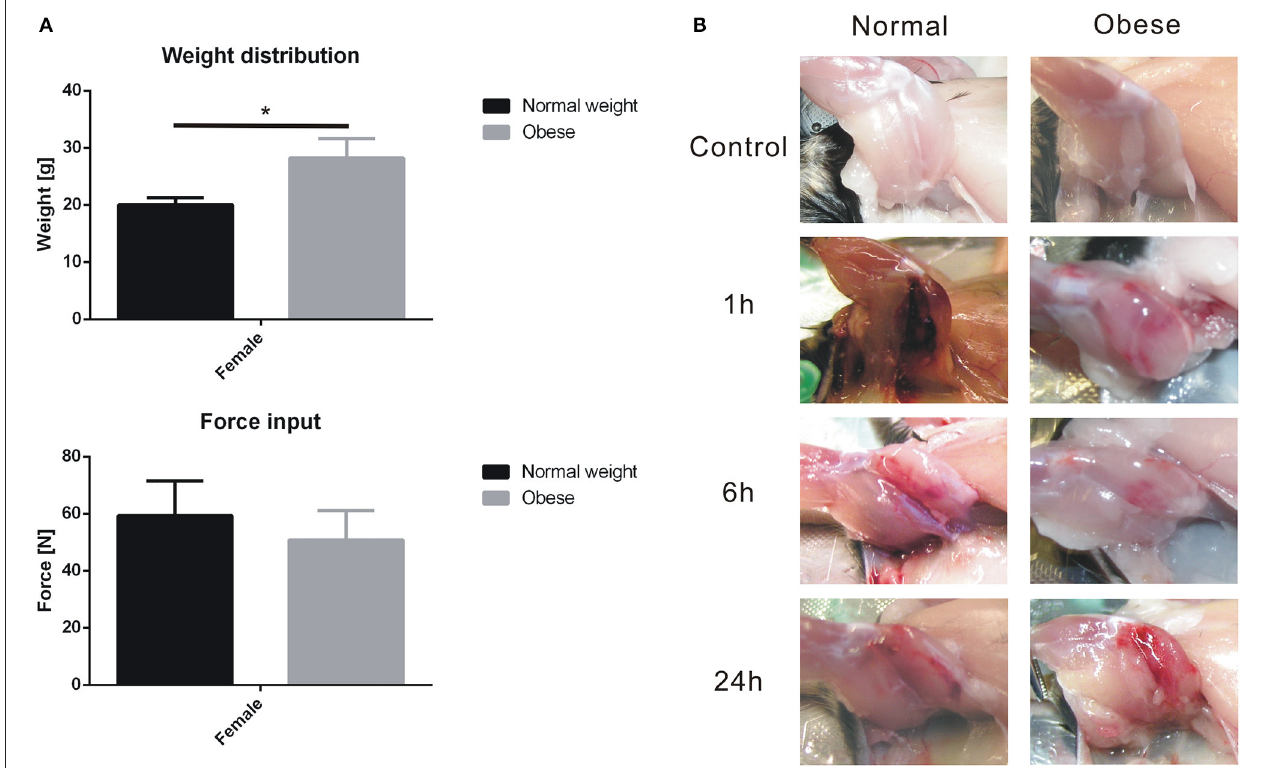
FIGURE 2 | Body weight, force input, and soft tissue trauma induction of the left hind leg of C57BL/6J mice. Values are given with mean ± standard deviation; n = 9. Statistical analysis by two-sided homoscedastic t -test. (A) Weight distribution for normal weight and obese animals (*indicates p ≤ 0.05); Force input into e xtensor iliotibialis anticus , values showed no significance. (B) Left hind limb of normal weight and obese C57BL/6J mice before and after trauma induction. Hematoma formation was observed within 24h.